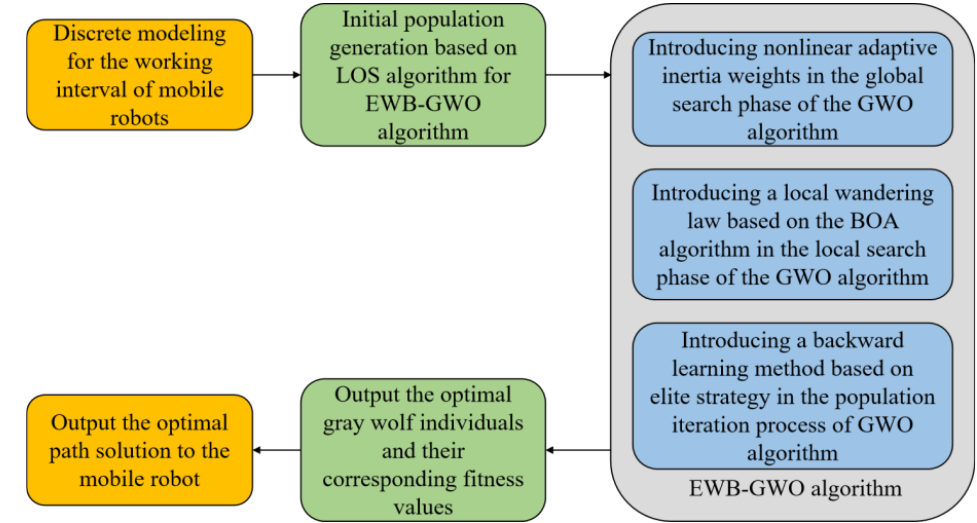
Figure 6. Workflow for mobile robot path planning based on EWB-GWO algorithm.